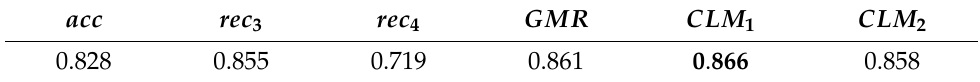
Table 6. Accuracy over the test set for each objective metric. The best value is highlighted in boldface.